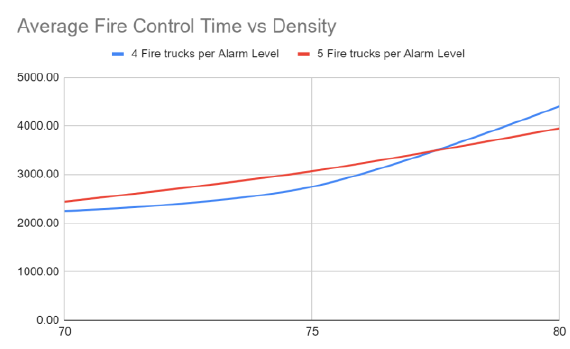
Figure 7 . Graph of fire control times at 70-80% density with increased fire truck